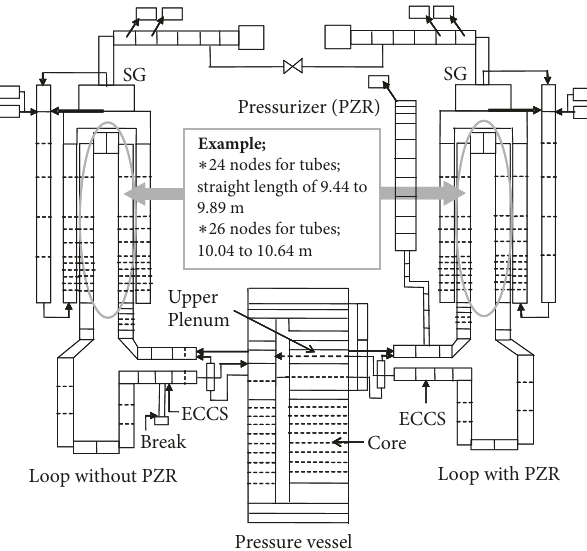
Figure 3: Noding schematic of LSTF for RELAP5 analysis